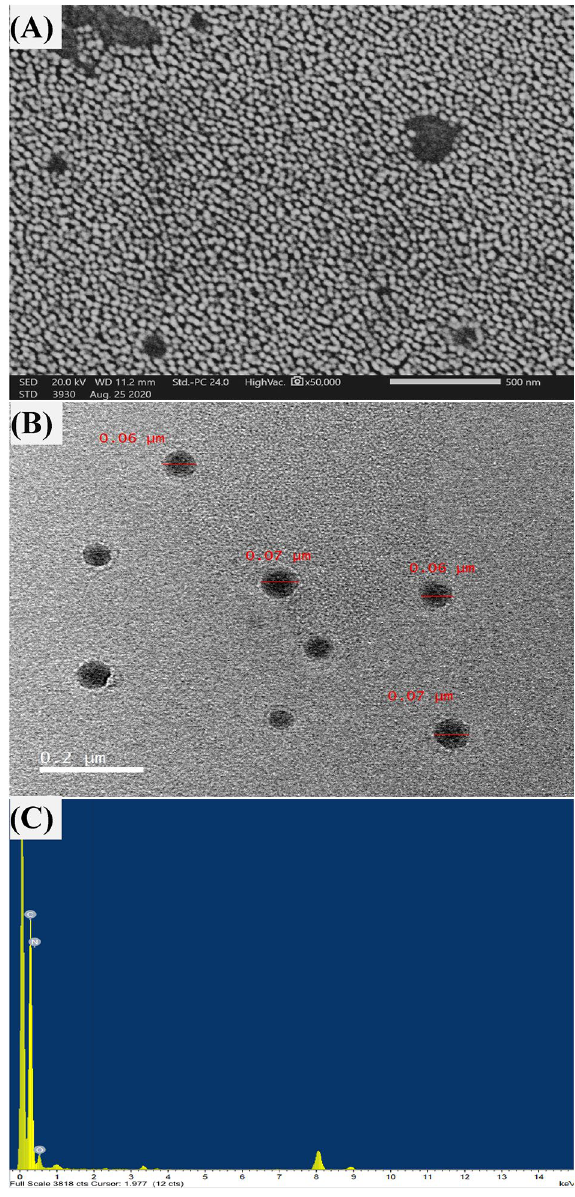
Figure 5. The biosynthesized chitosan nanoparticles using Streptomyces microflavus strain NEAE-83, as detected by the micrographs of SEM ( A ), TEM ( B ) and EDXS ( C